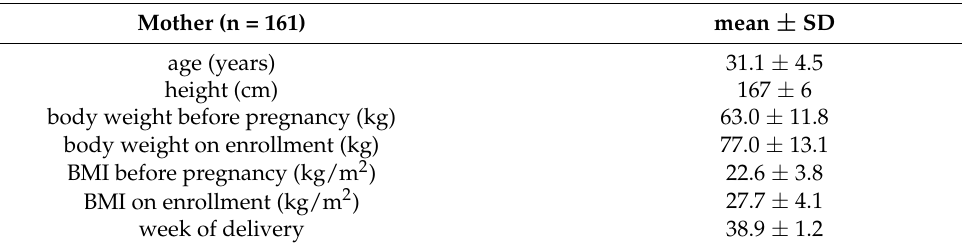
Table A1. Characteristics of